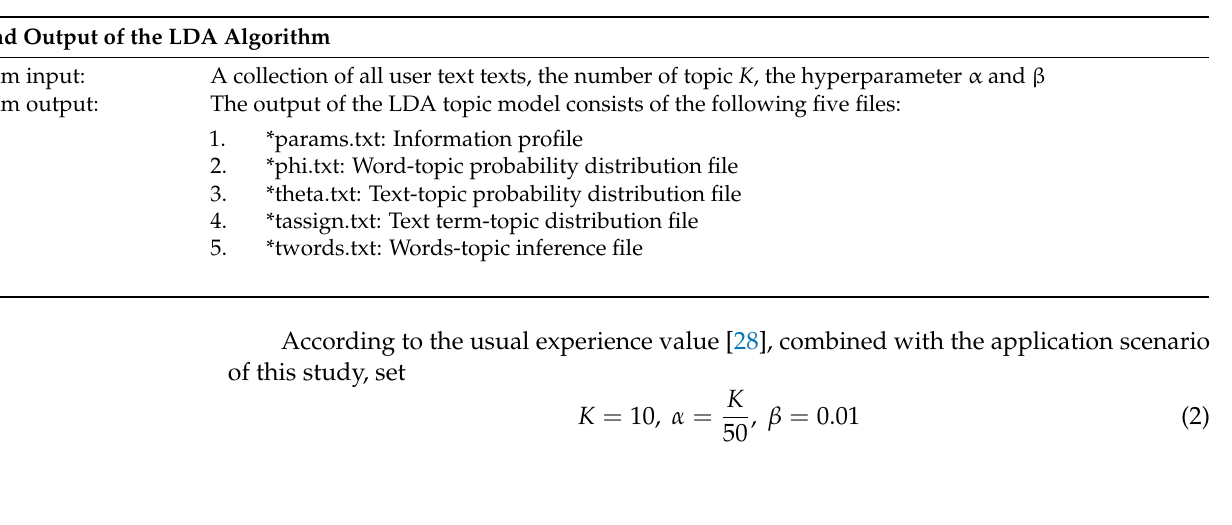
Table 4. Input and outputs of the LDA topic model